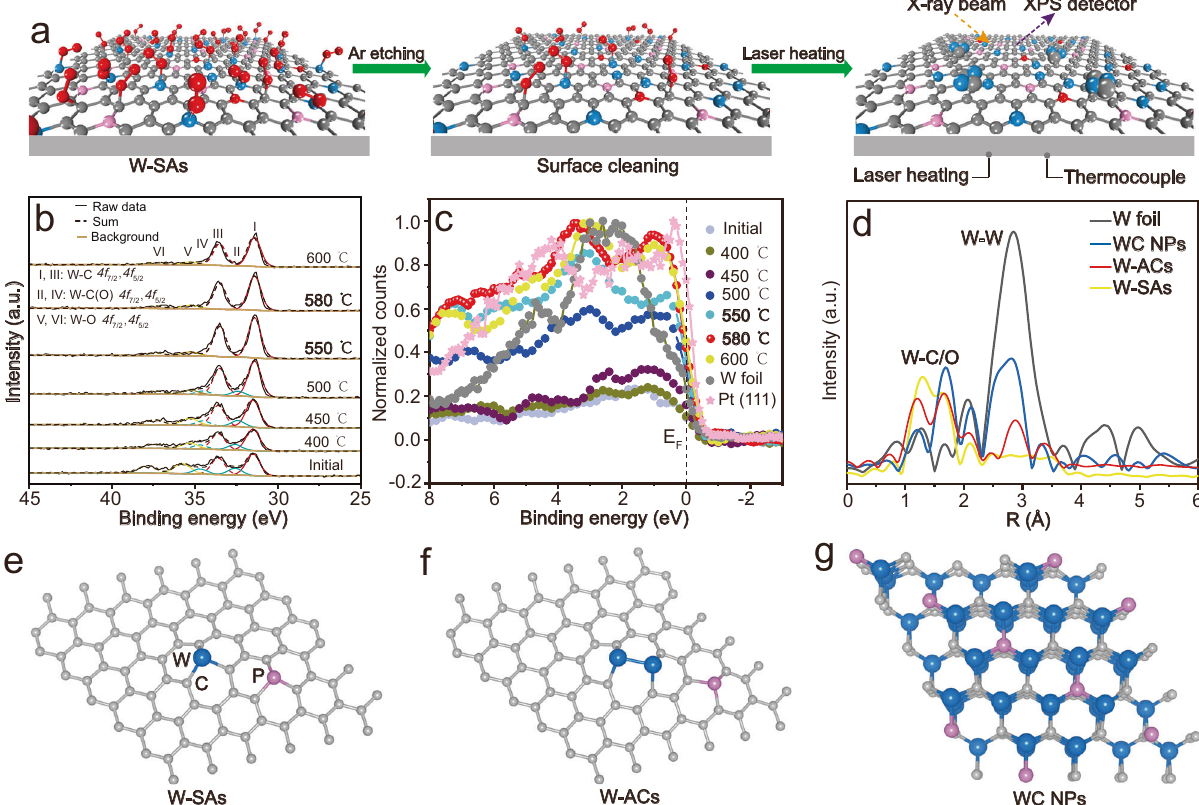
Fig. 2 Structural characterization of the synthesized W-ACs. a Schematic illustration of the in-situ variable-temperature NAP-XPS measurements at H 2 atmosphere (0.1 mbar), where O, C, P and W atoms are represented by red, gray, pink, and blue spheres, respectively. b W 4 f core-level XPS spectra for tungsten species treated at temperature ranging from 400 to 600 °C. c XPS valence band spectra of various tungsten species and the reference samples of W foil and Pt (111). d FT-EXAFS spectra at the W L 3 -edge of W-SAs, W-ACs, WC NPs, and W foil. Typical atomic models of ( e ) W-SAs, f W-ACs. g WC NPs. W (blue), C (gray), and P